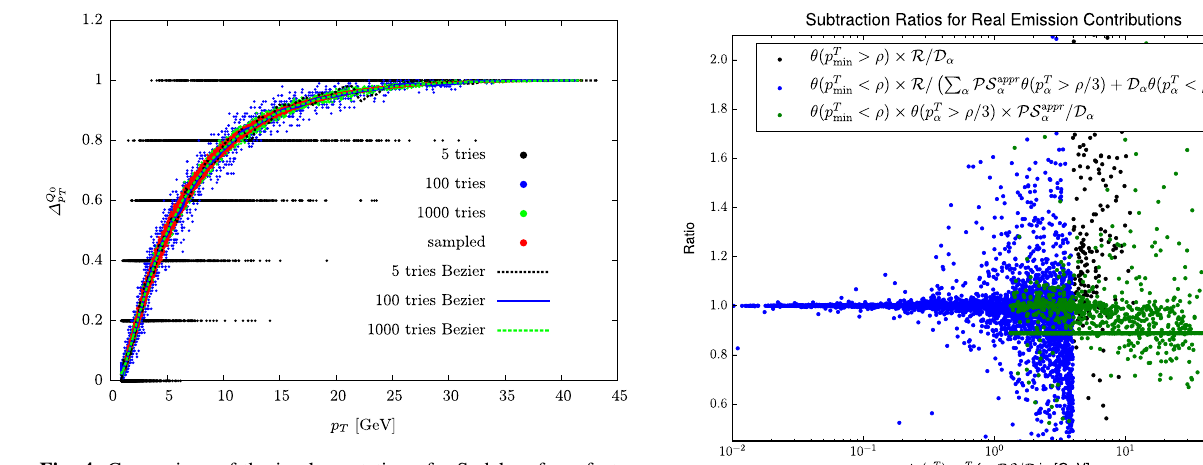
Fig. 4 Comparison of the implementation of a Sudakov form factor for a q ¯ q pair with Q 0 = 91 . 2GeV. The black, blue and green points correspond to CKKW-L type Sudakov suppression, where the number of no emissions above the scale p T is counted. The red points are eval- uated Sudakov suppressions by directly sampling the exponent with a MC error of 5%. The three Bézier lines, which are in perfect agreement are produced by the corresponding gnuplot averaging procedure